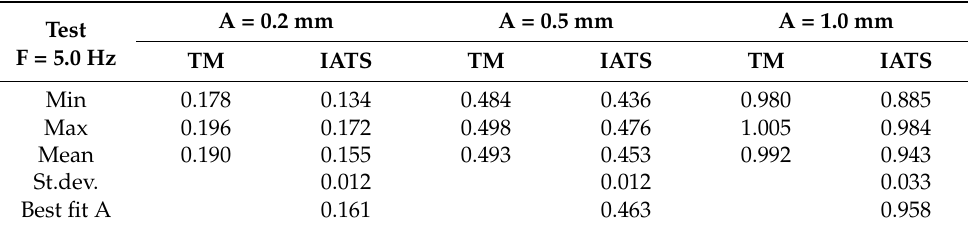
Table 1. Achieved min, max, and mean amplitudes with standard deviations and best fit sinusoidal amplitude for test F = 5 Hz, A = 0.2, 0.5, and 1.0